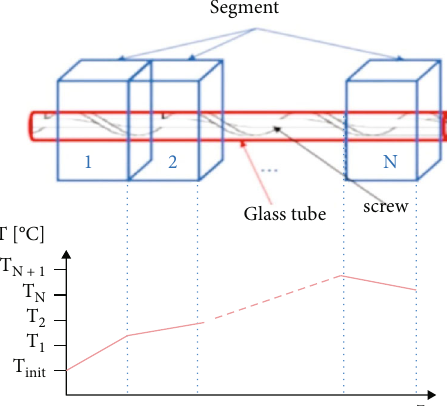
Figure 14: Schematic representation of the microwave applicator developed by Ramopoulos et al. [77] with the temperature pro fi le (reprinted with permission. Copyright © Cambridge University Press and the European Microwave Association